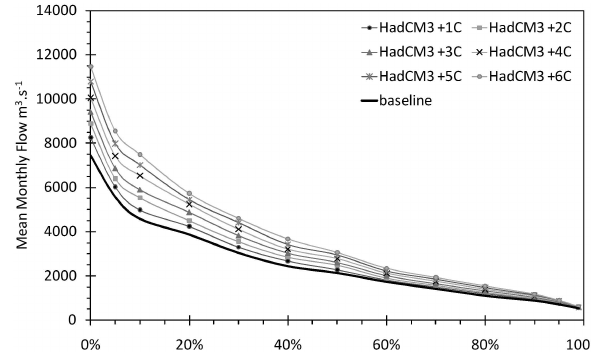
Fig. 6. Projected mean monthly flow duration curves under pre- scribed increases in global mean air temperature using HadCM3 in the Rio Grande basin along with the detrended 1961–1990 baseline or control